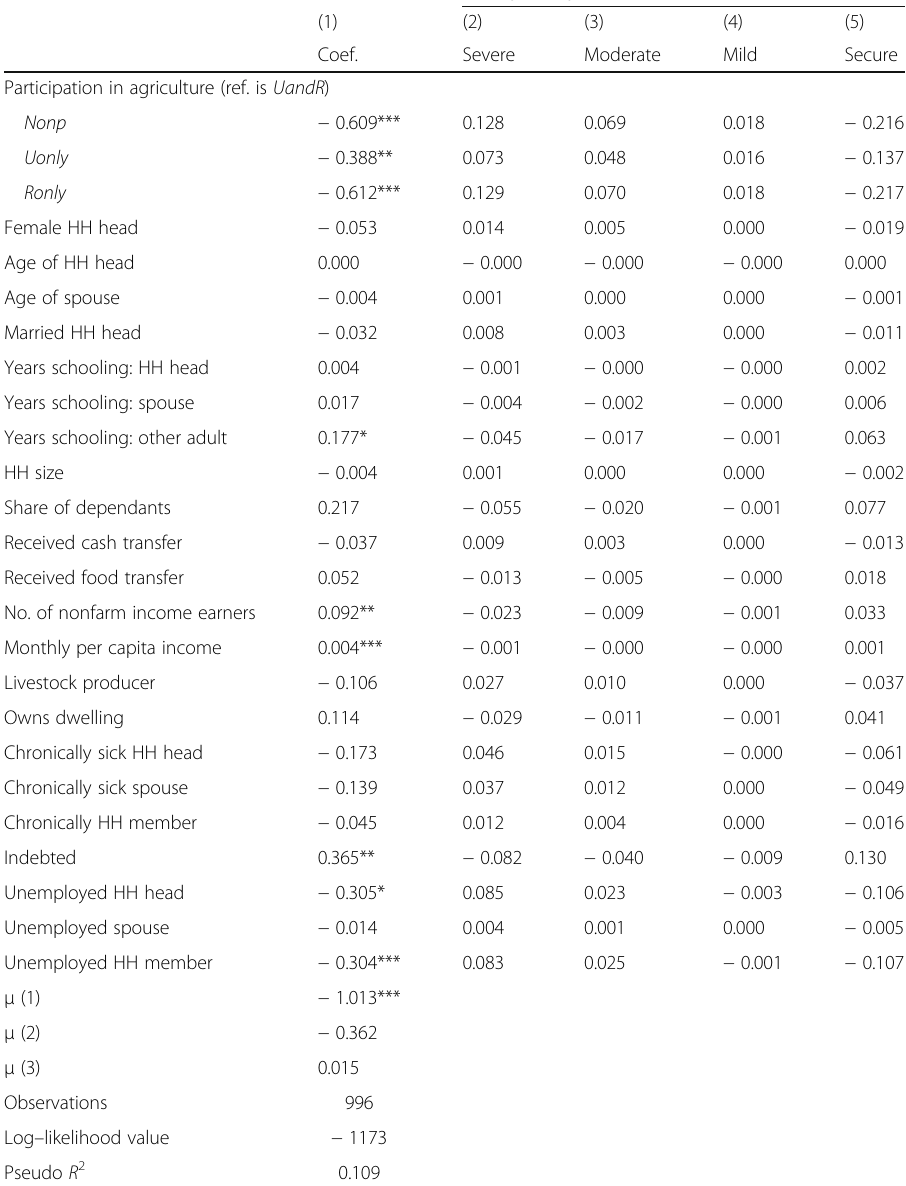
Table 6 Ordered probit estimates of participation in agriculture and food security (Tamale)